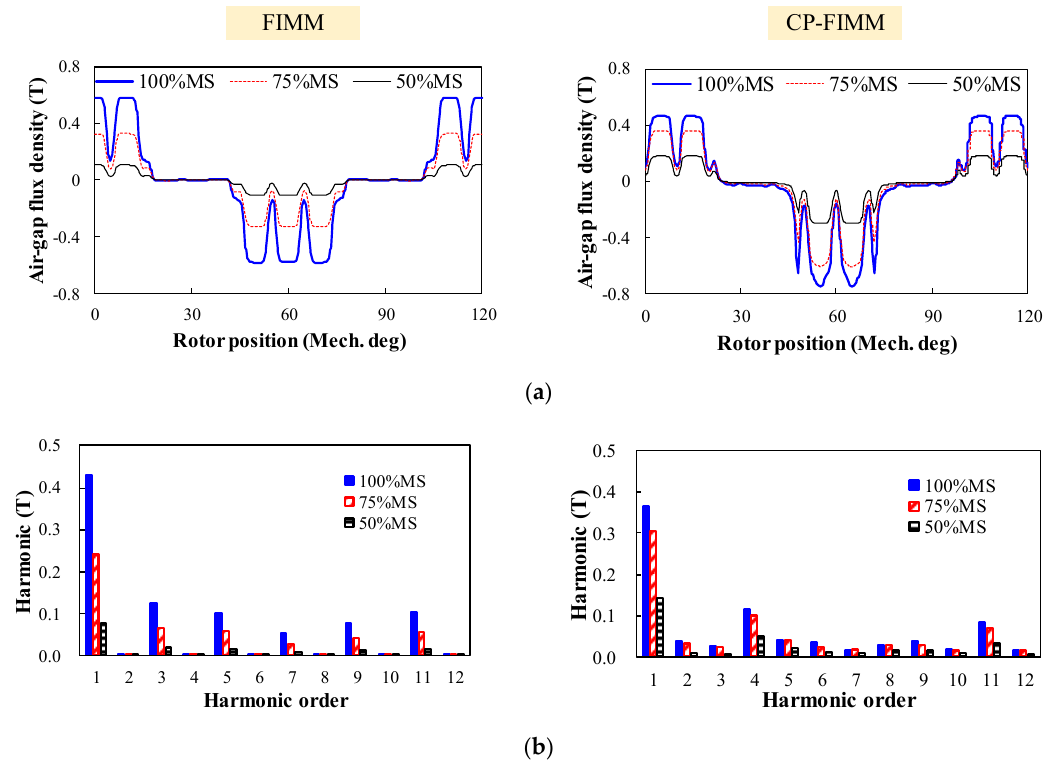
( b ) Figure 7. Flux linkage of the two machines. ( a ) Waveforms; ( b ) harmonic spectra. Figure 8 shows the air-gap flux density waveforms of the FIMM and CP-FIMM. Due to the existence of iron poles, the air-gap flux density of CP-FIMM shows an asymmetry and has more even-order harmonics. In addition, the fundamental amplitude of air-gap flux density of CP-FIMM is slightly lower than FIMM since 40% of AlNiCo PM is replaced by iron poles. Since more AlNiCo PMs are involved in MS manipulation in the FIMM, the flux densities under 75% and 50% MSs of FIMM are lower than the CP-FIMM, respec-